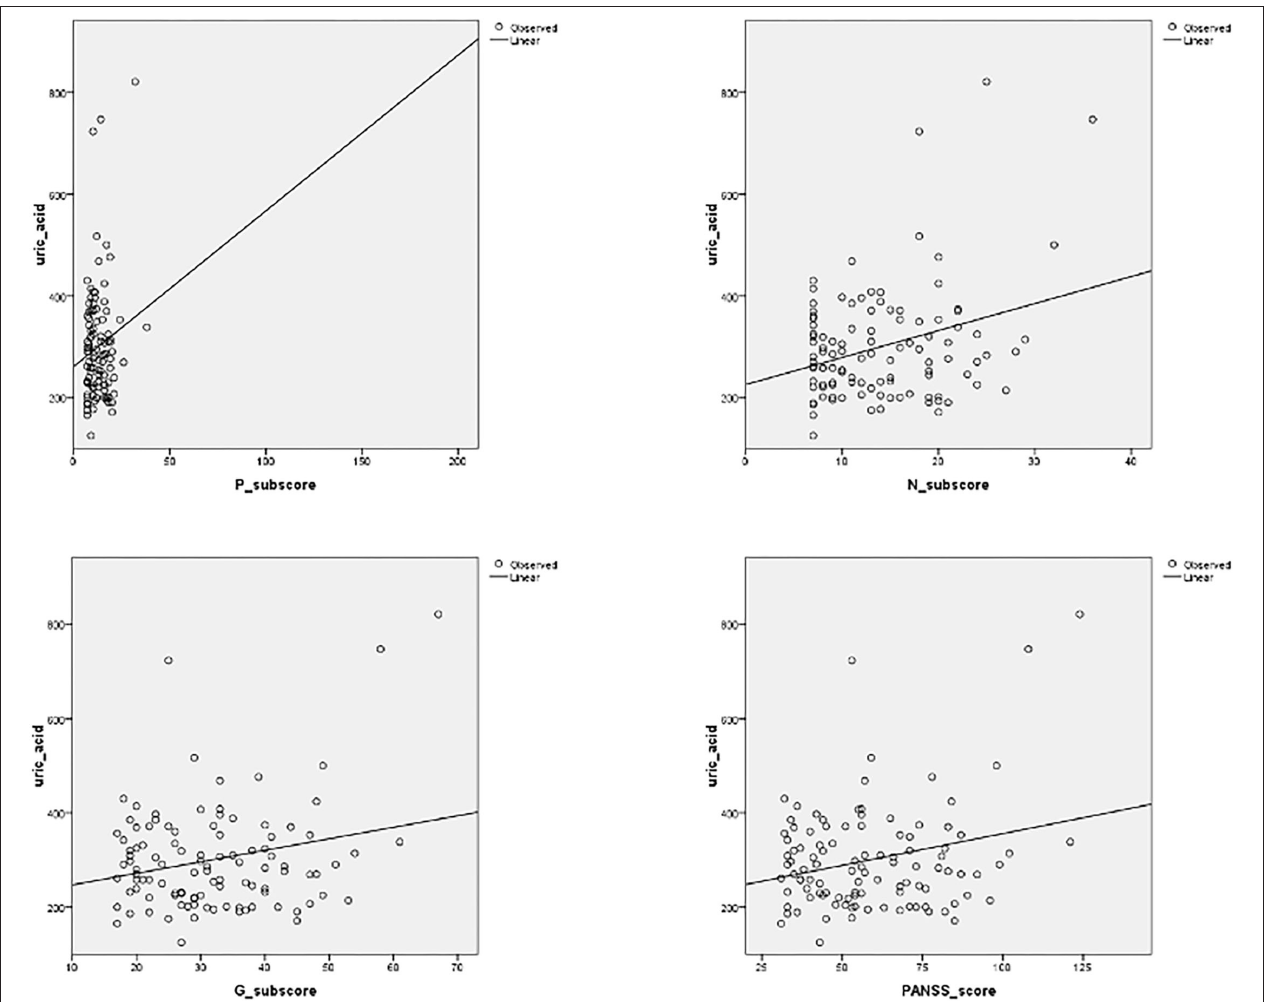
FIGURE 1 | Correlation between serum uric acid (UA) levels and positive, negative (N), and general (G) sub-scores, and total PANSS (Positive and Negative Syndrome Scale) score, after 1 month of antipsychotic treatment. Significant correlation was established between UA serum levels with negative sub-score ( p = 0.001, r = 0.306), general sub-score ( p = 0.015, r = 0.236), and total PANSS score ( p = 0.009, r = 0.3) after 1 month of therapy.